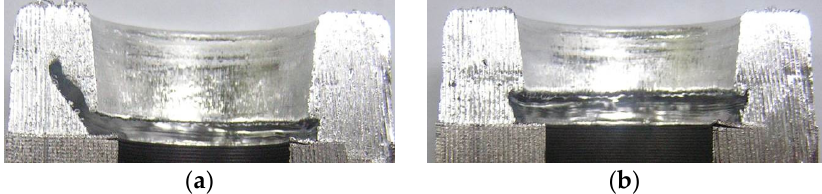
Figure 9. The inner part of the upper end ring. ( a ) conventional centrifugal casting method; ( b ) proposed casting method.